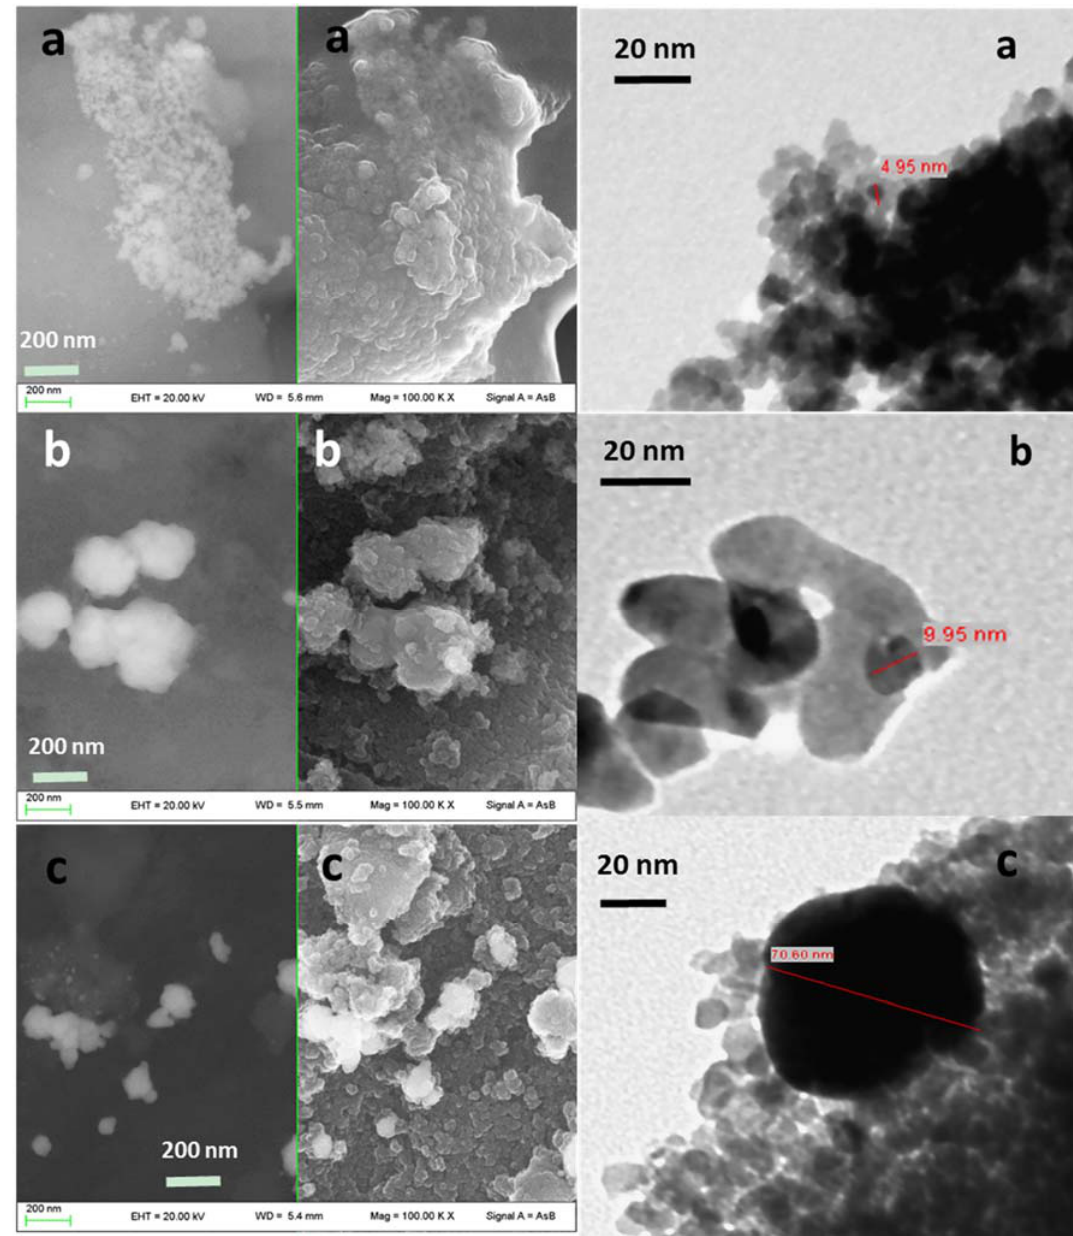
Figure 6. Double SEM images obtained by two detector (AsB and Inlens) and TEM: ACeTHPC (section a ); AZrTHPC (section b ) and ATiTHPC (section c ).